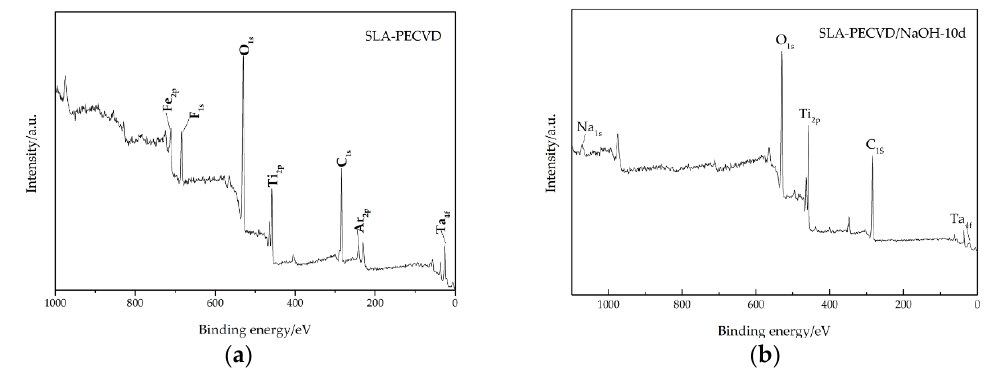
Figure 2. XPS spectrum on the surface of the SLA-PECVD ( a ) and SLA-PECVD/NaOH-10d ( b ) samples. The surface of SLA-PECVD/NaOH-10d sample was covered by foreign depositions with clear peaks representing Na.